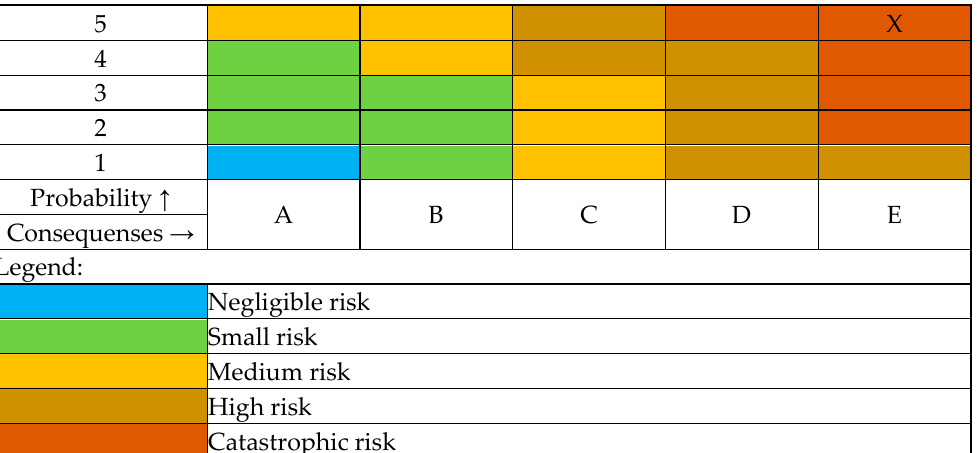
Table 13. Risk score for the Bra´nszczyk commune.